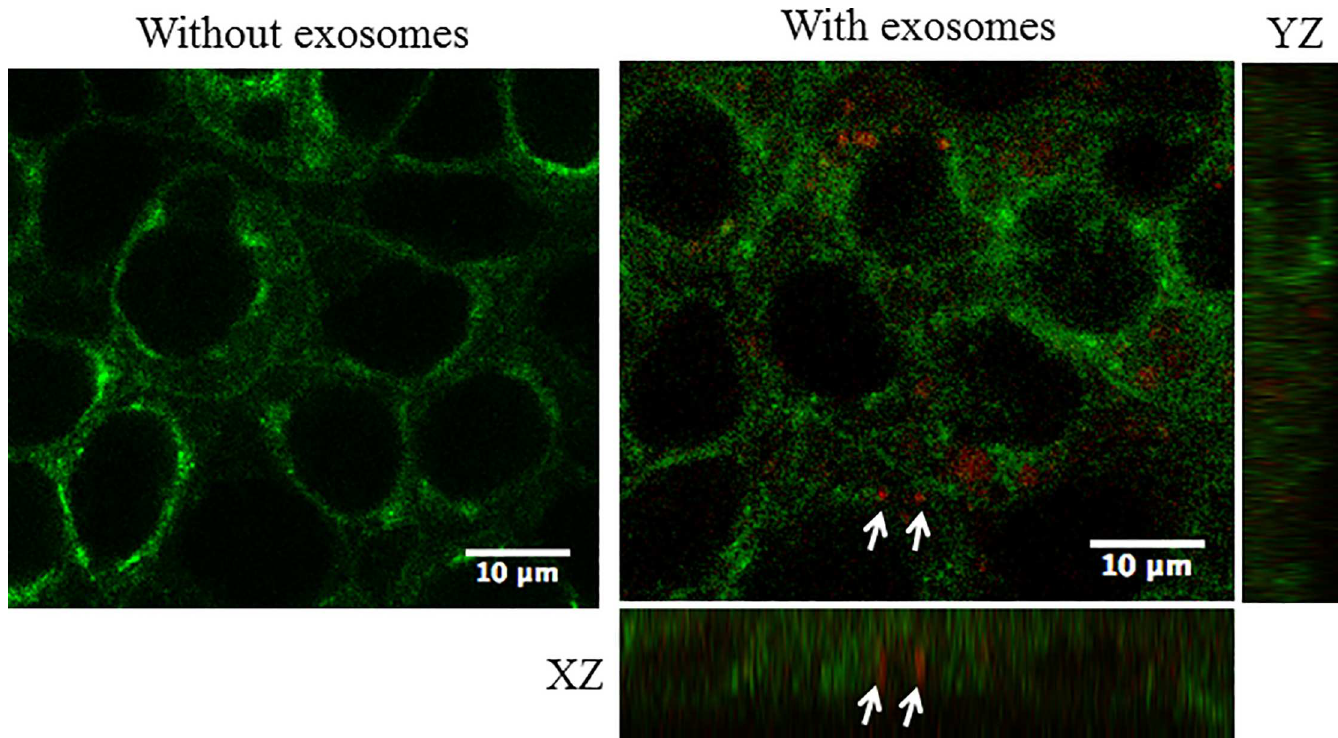
Fig 5. Uptake of fluorescently labeled exosomes from LLC-PK1 cells in mouse cortical collecting duct principal cells. mpkCCD cells were incubatedwith red PKH26-labeled exosomes at 37˚C for one hour. The cell surface was labeledwith the green CTX fluorescent dye. Arrows indicate exosomes taken up by the cells after a 1 hour incubationat 37˚C. Twelve z stack images were taken in total and an orthogonal view (XZ and YZ axis) is shown.